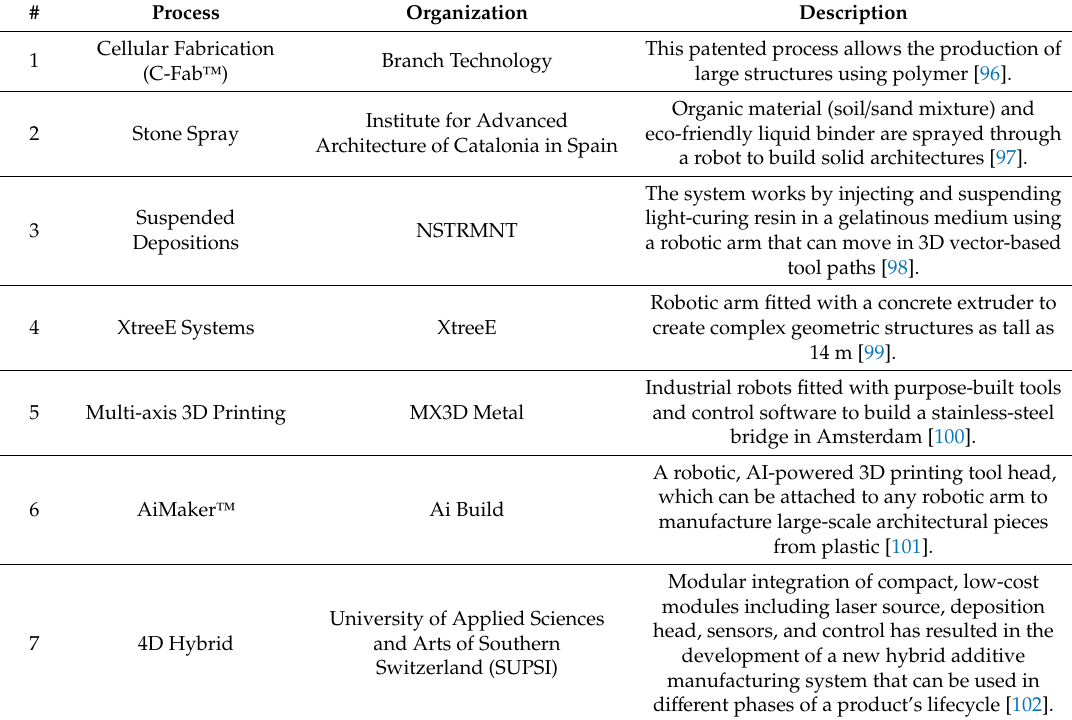
Table 2. Robot use in additive manufacturing